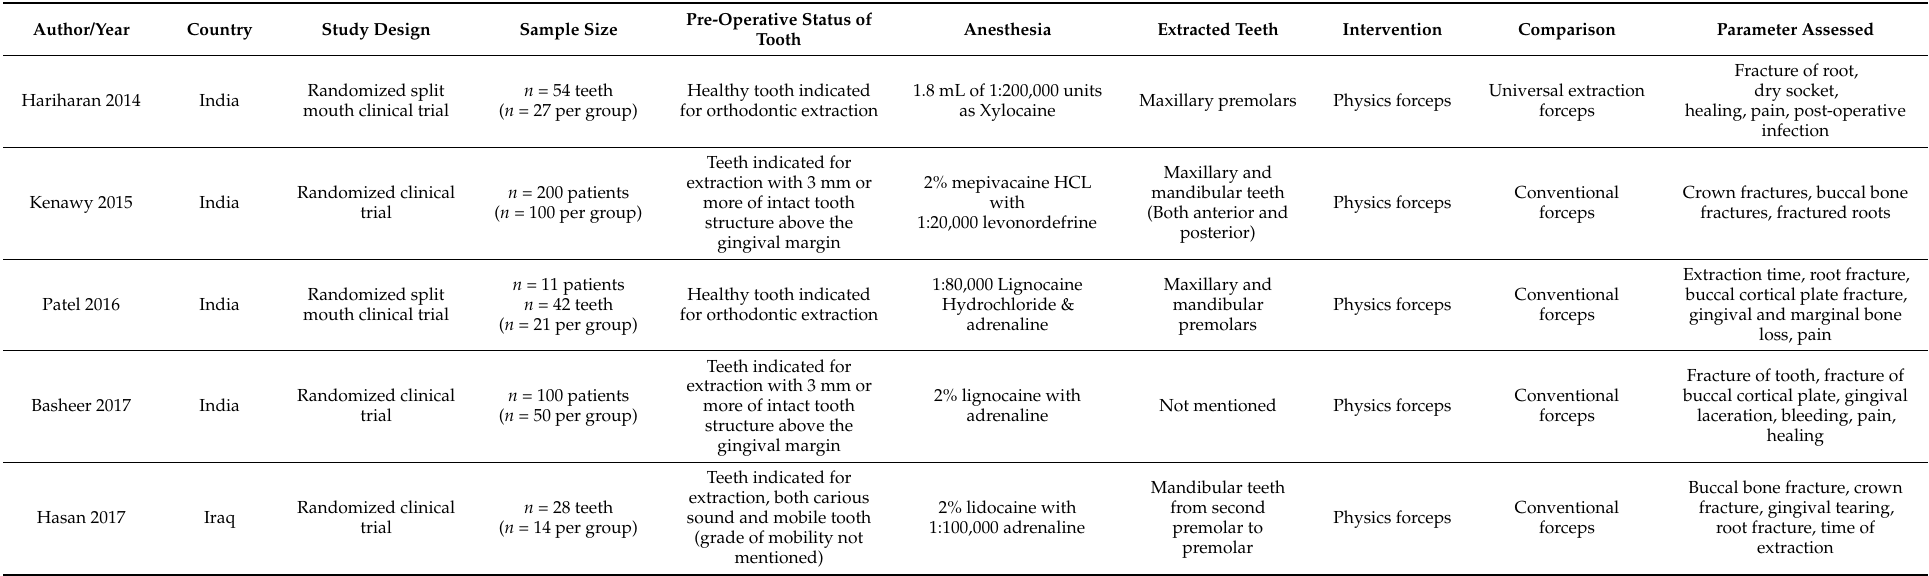
Table 2. Characteristics of included